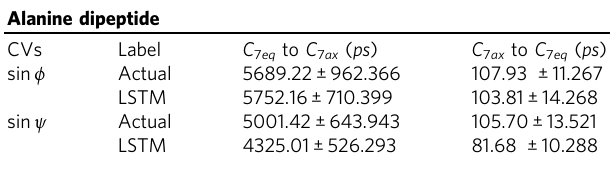
Inverse of transition rates for conformational transitions in alanine dipetide calculated from actual MD trajectories of LSTM model. Here we show the calculation along two different CVs: sin ϕ and sin ψ